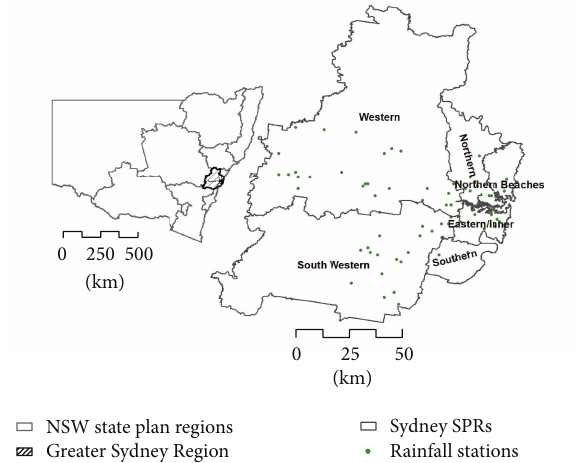
Figure 1: Locational map of the Greater Sydney Region (GSR), rainfall station sites, and state plan regions within